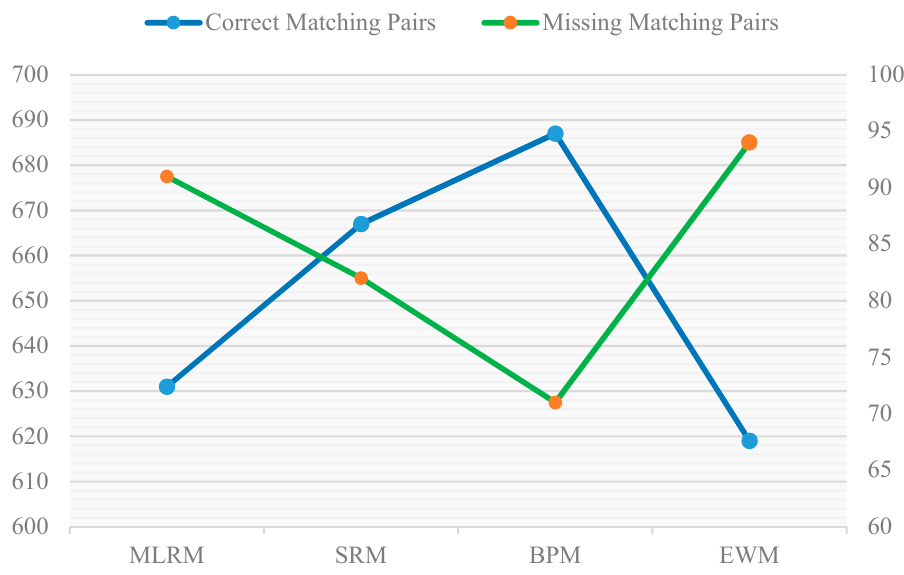
Figure 9. Comparison of the number of correct matching pairs and missing matching pairs of MLRM, SRM, BPM, and EWM.